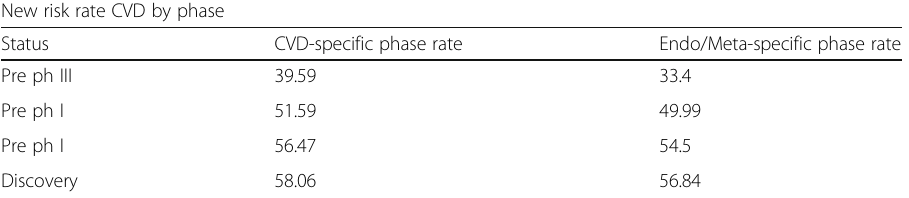
Table 7 Dynamic risk rates: rates that could be applied to the relevant stage being valued as a function of WACC and ROI (risk rates are indicated from their status in development to